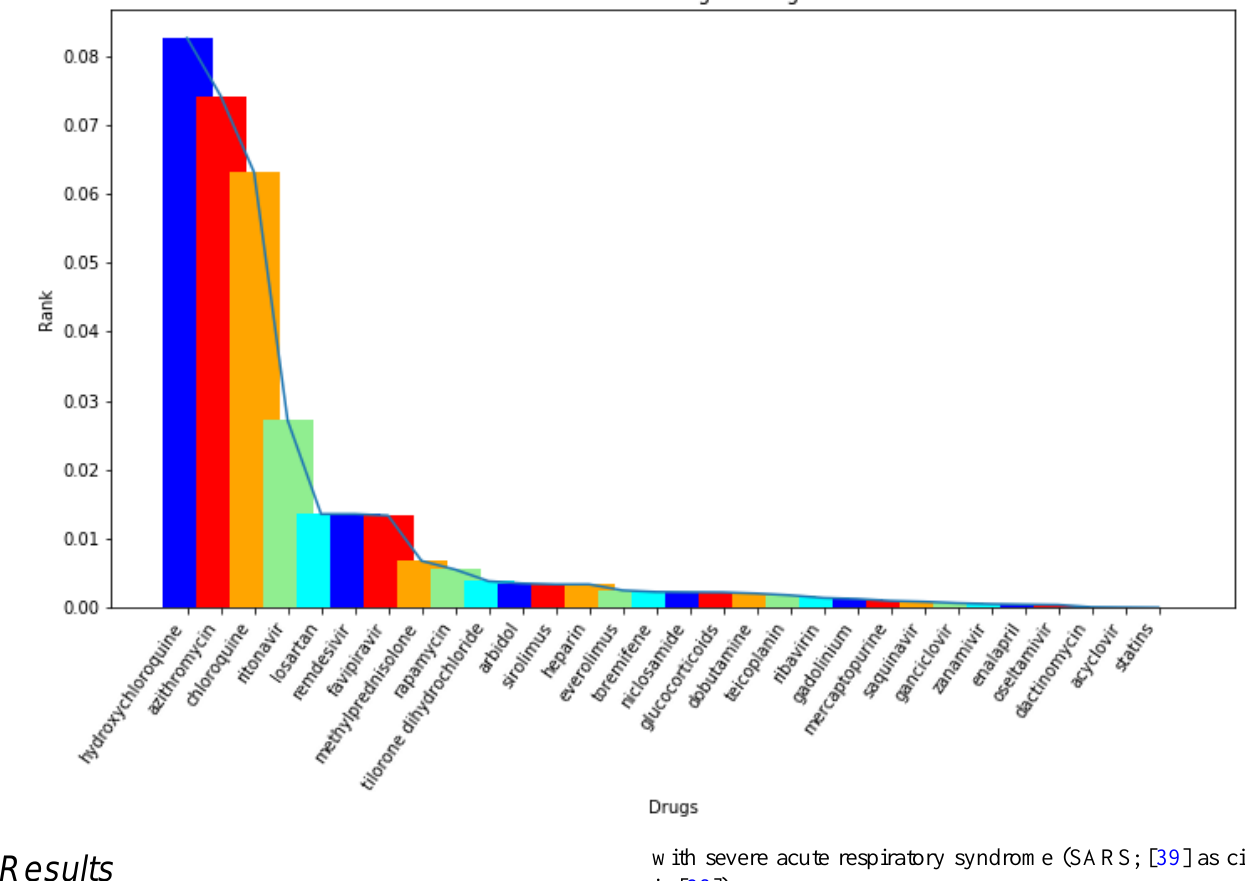
Figure 4. The drugs that are found in the literature and the derived ranking using the CovidX algorithm. The algorithm takes into consideration the diversity notion introduced earlier and the frequency of a drug that is currently being studied in a clinical trial. The combination of these two factors has produced a ranking mechanism to enable the selection of candidate drugs for repurposing. The diagram shows the top-10 listed according to the